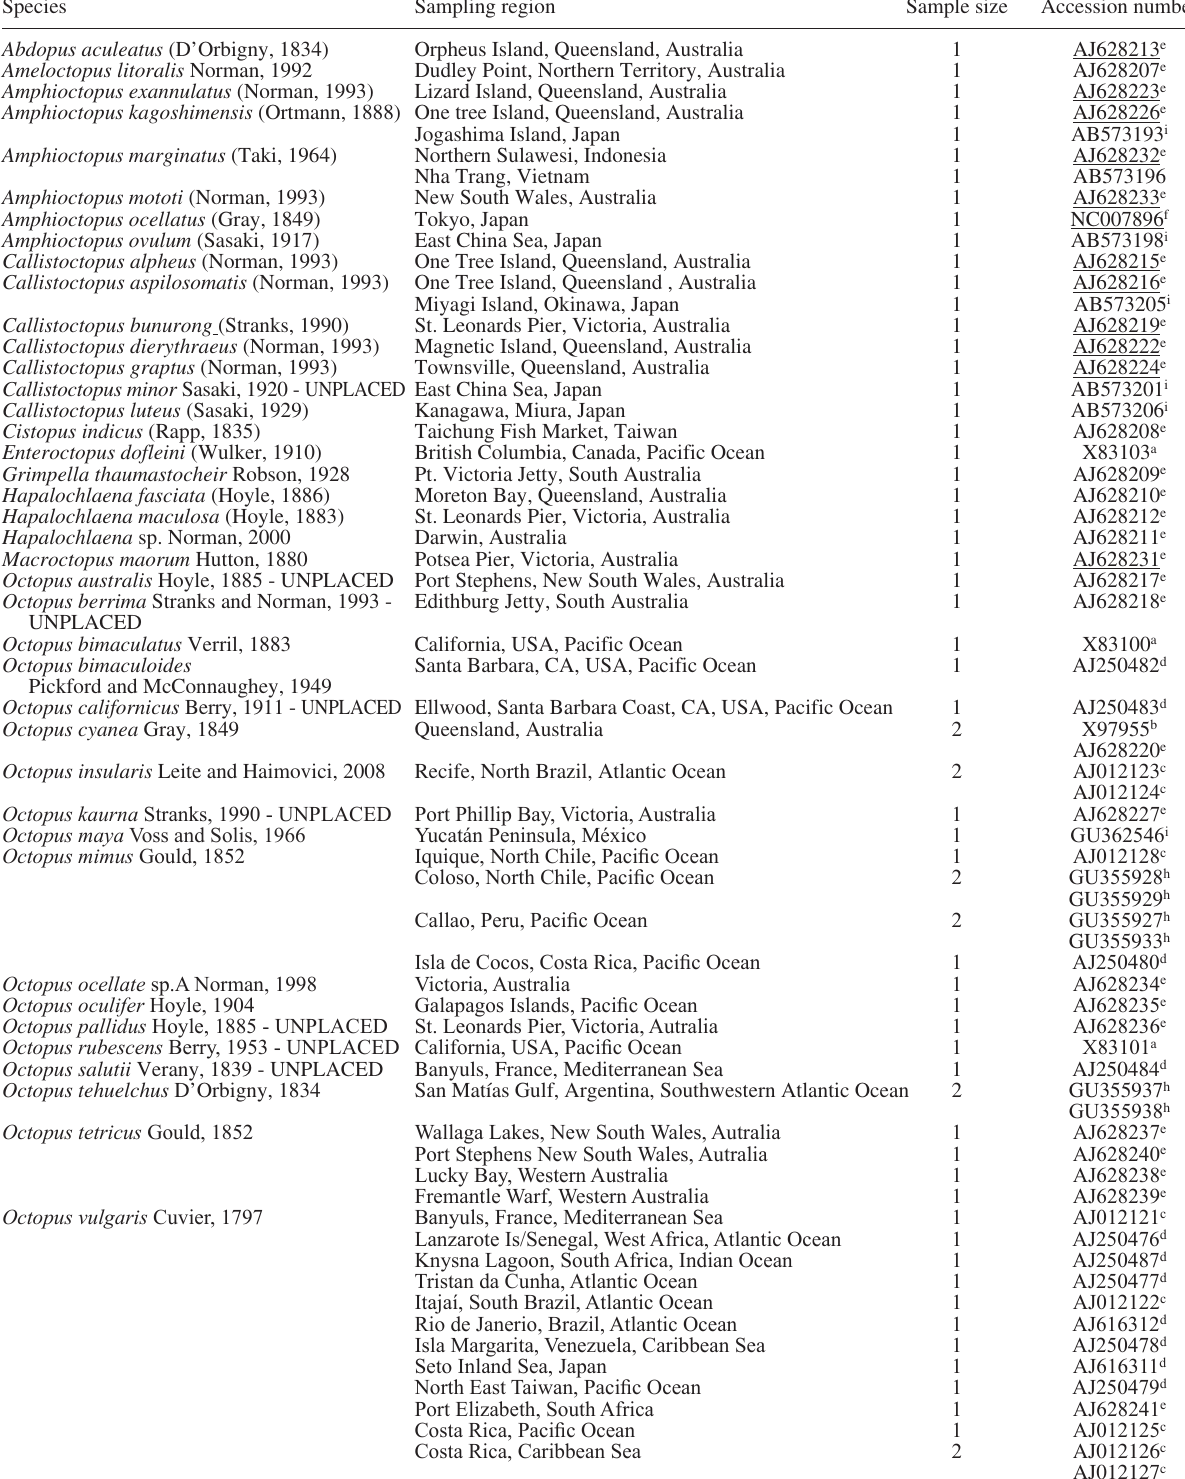
Table 1. – Specimens, sampling regions, sample sizes and accession numbers of DNA sequences included in the phylogenetic inferences with COIII. Sequences reassigned to other genera by Norman and Hochberg (2005) that are still identified as Octopus in GenBank have their accession numbers underlined; specimens marked as “unplaced” are those of uncertain position but left in the genus until further revision by the same authors. Species used as outgroups are listed at the bottom of the table.